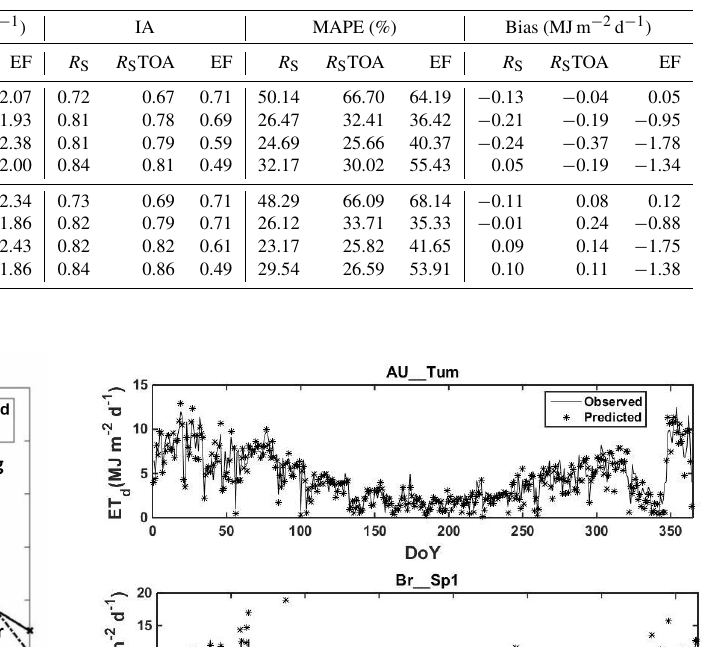
Table 2. A summary of ET d error statistics by comparing the performance of R S -based, R S TOA-based and EF-based ET i upscaling methods with regard to different sky conditions. Here τ 1 represents low atmospheric transmissivity due to high cloudiness while τ 4 represents high transmissivity under clear sky conditions.